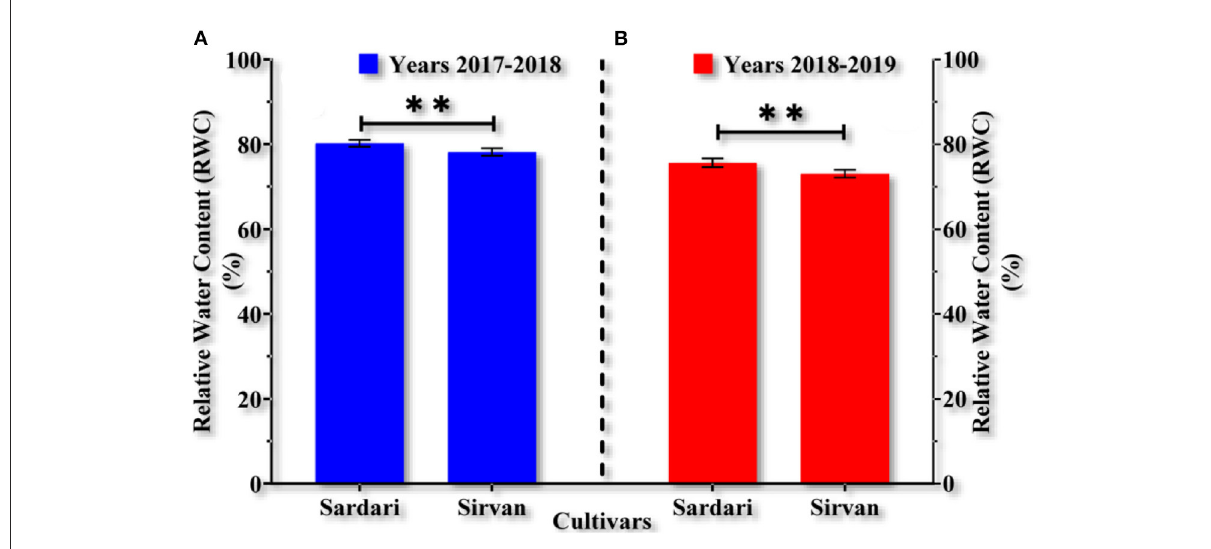
FIGURE1 Mean comparisons main effects of cultivars (A,B) on relative water content in wheat plant in the years 2017–2018 and 2018–2019. **0.001 < p ≤ 0.01.